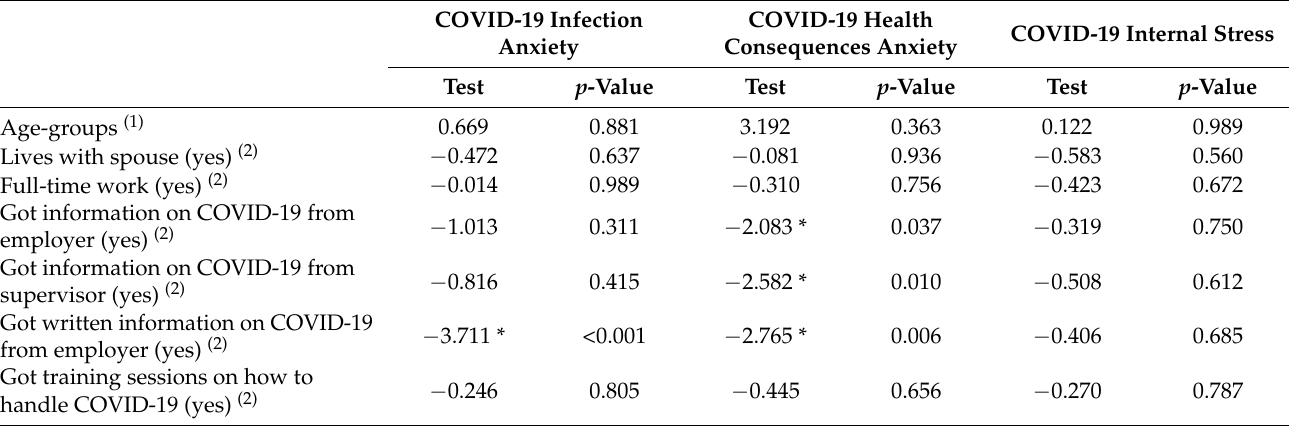
Table 8. Statistical